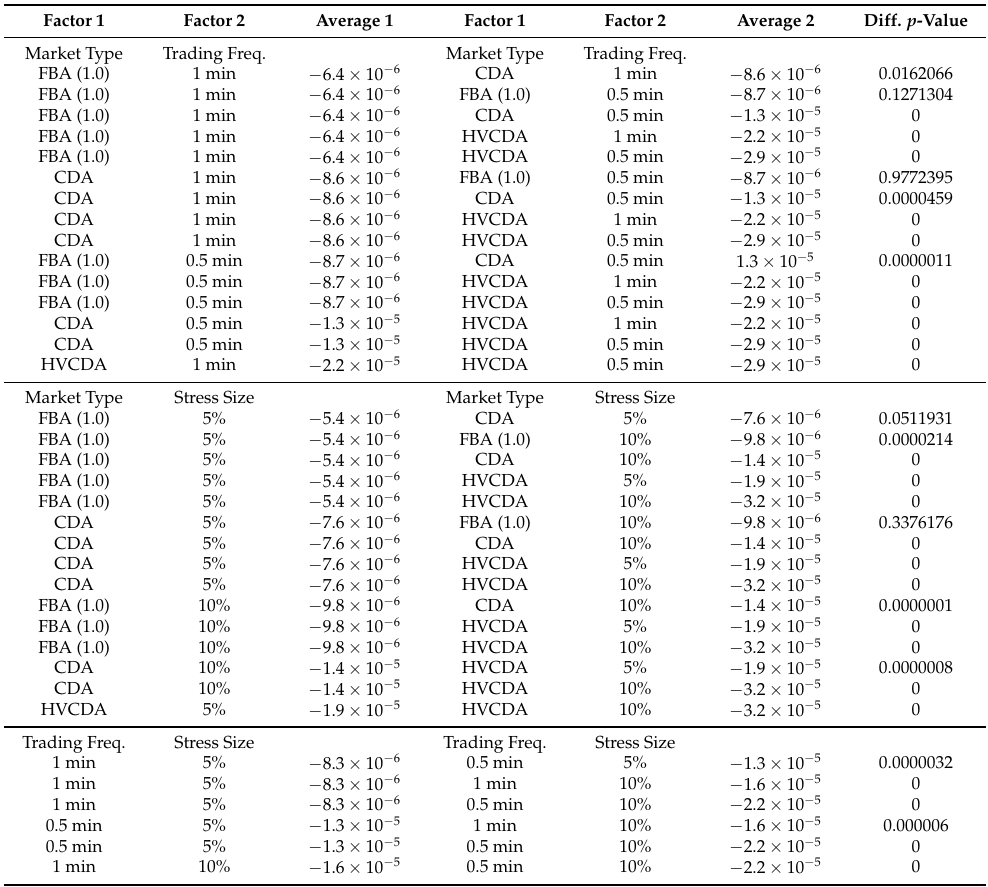
Table A1. Tukey’s HSD test applied to the resulting interaction terms of the analysis of variance in Table